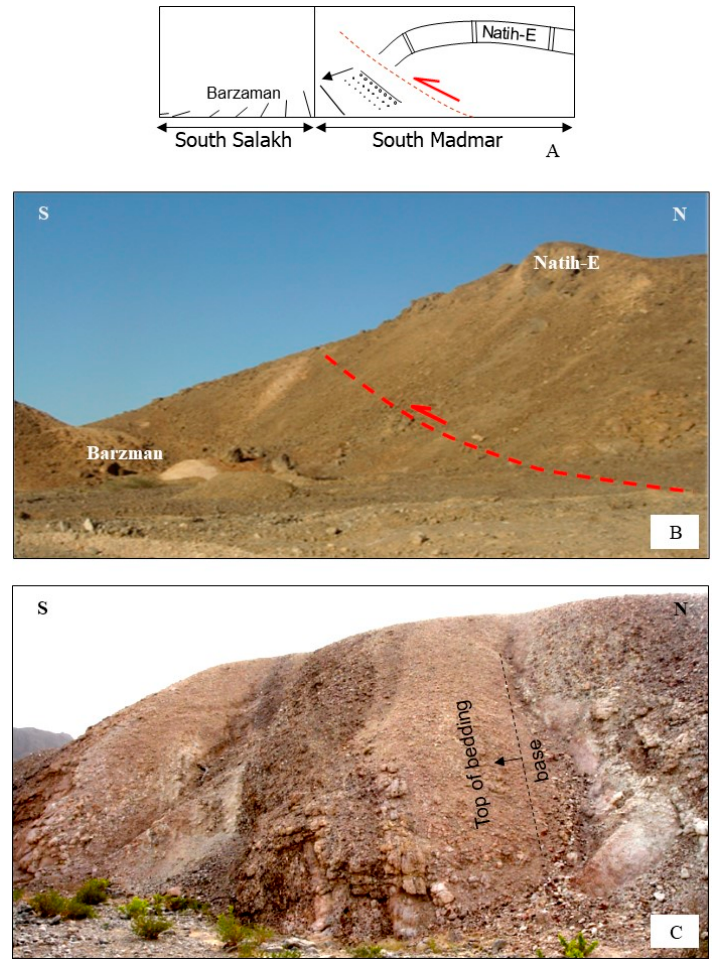
Figure 23. ( A ) The collapsed blocks in southern areas of Salakh E and Madmar formed in areas where the Natih Formation is found to overthrust the outcropping unconsolidated conglomerate and marls of the Barzaman and Fiqa formations. ( B ) Natih-E beds overthrusted above Barzaman Fm in South Madmar. ( C ) Isolated outcrops of overturned Barzaman Fm in South Salakh. In both locations, the Barzaman and Fiqa beds approximately strike parallel to the main fold axes. These soft rocks get eroded easily and the overlying thrusted carbonate beds consequently collapse.